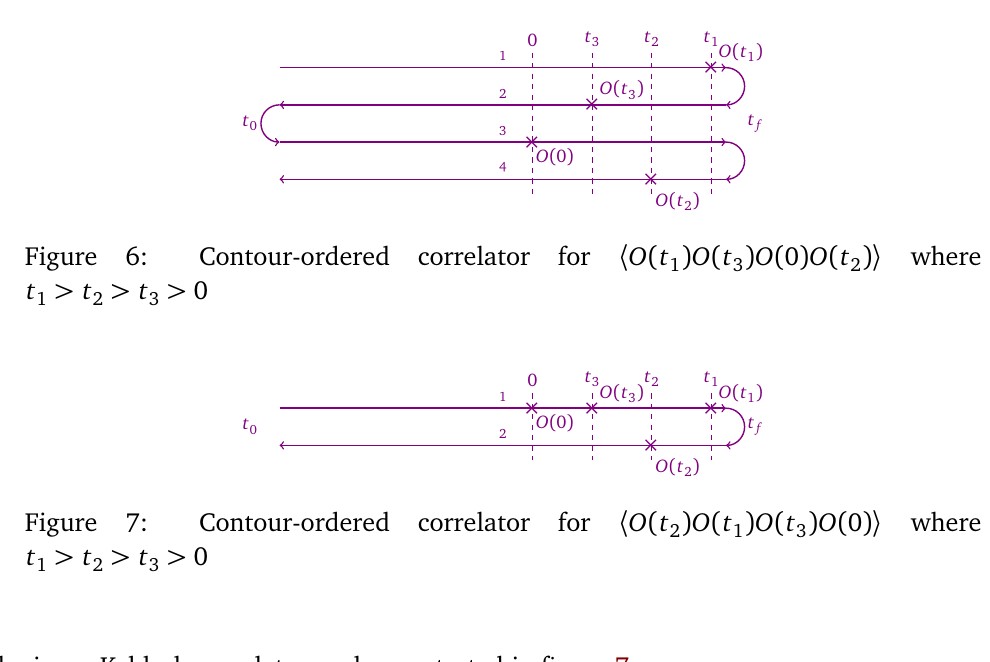
Figure 7: Contour-ordered correlator for 〈 O ( t > t > t > t 1 2 3